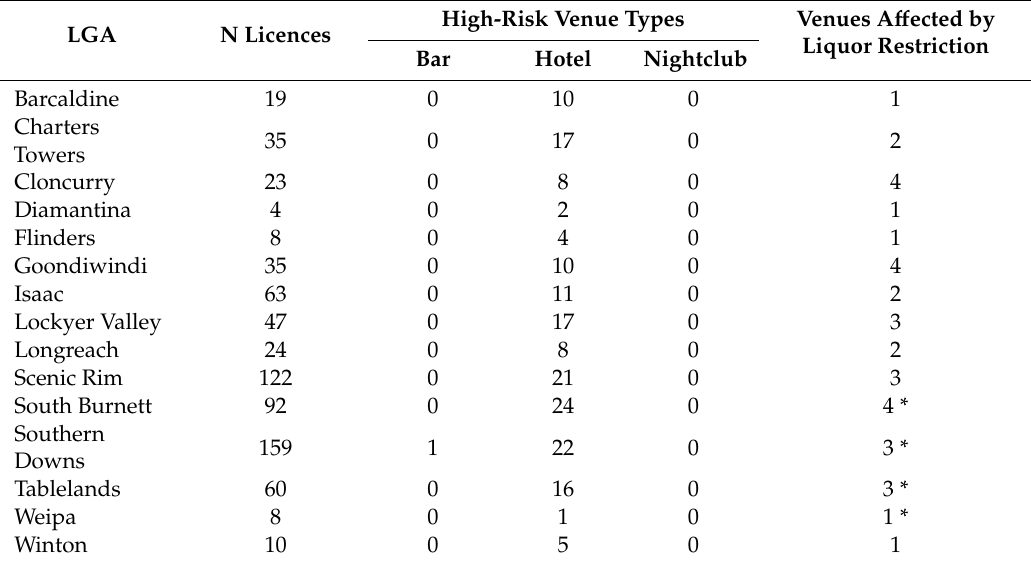
Table 2. Venue details for LGAs with closing times after 00:00 and not after 2:00 before July 2016. LGA N Licences